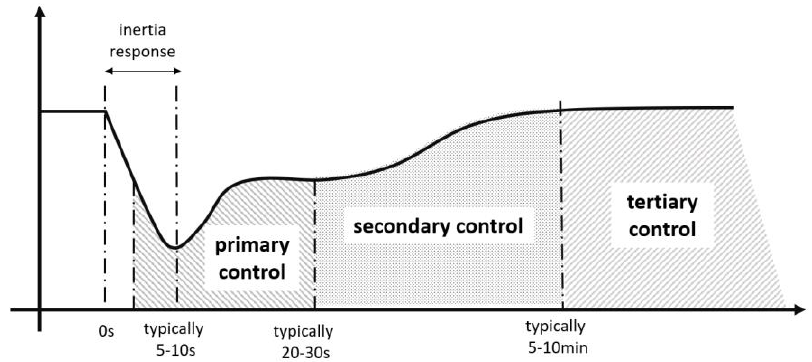
Figure 1. Typical power system frequency response to a sudden loss of generation .